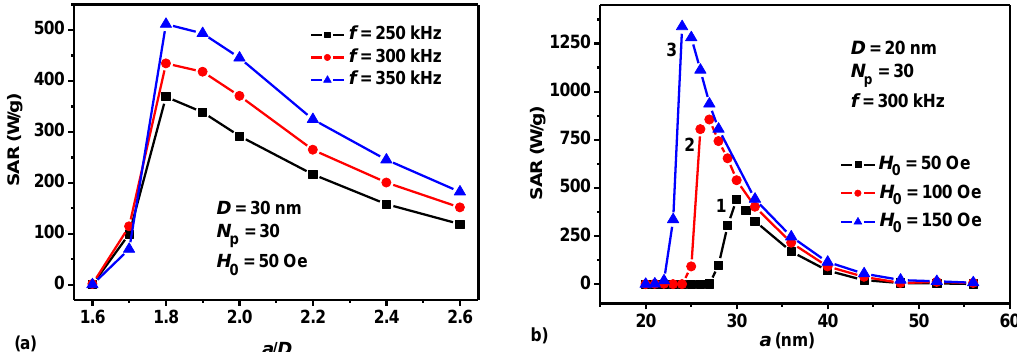
Figure 2. ( a ) Frequency dependence of SAR for assembly of magnetosome chains with particle diameter D = 30 nm in an AC magnetic field with an amplitude H 0 = 50 Oe. ( b ) Dependence of SAR on the distance a between the particle centers for particles with diameter D = 20 nm for various amplitudes of AC magnetic field: (1) H 0 = 50 Oe, (2) H 0 = 100 Oe, (3) H 0 = 150